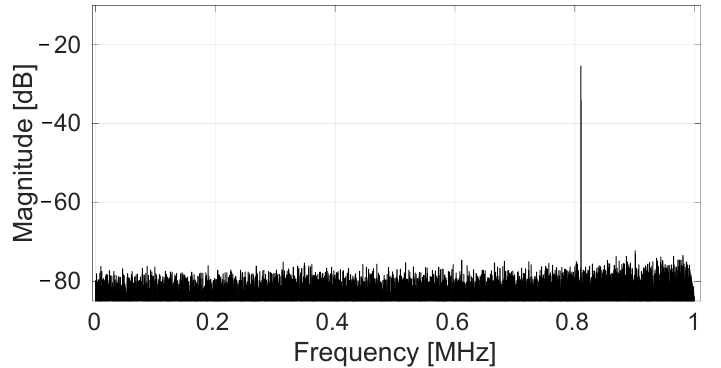
Figure 14. Measured output spectrum (32K FFT) for a magnetic input at 810kHz with amplitude 780 µ T. All SS-ORLs are active, removing the randomized offset. The 0dB reference level corresponds to a full-scale signal output amplitude of